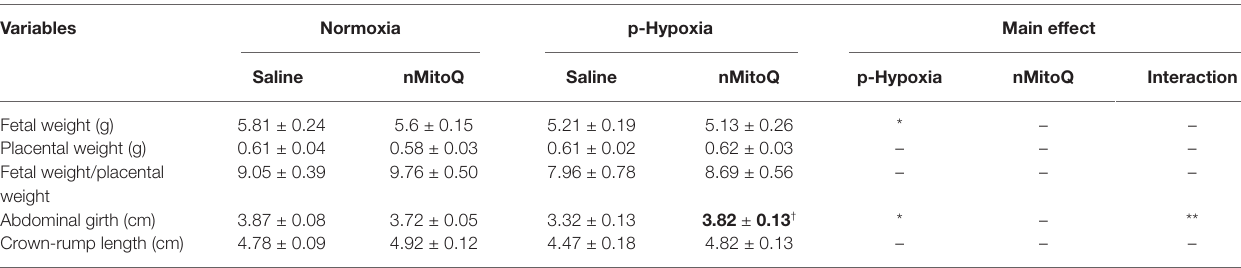
TABLE 2 | Fetal and placental characteristics of male offspring.